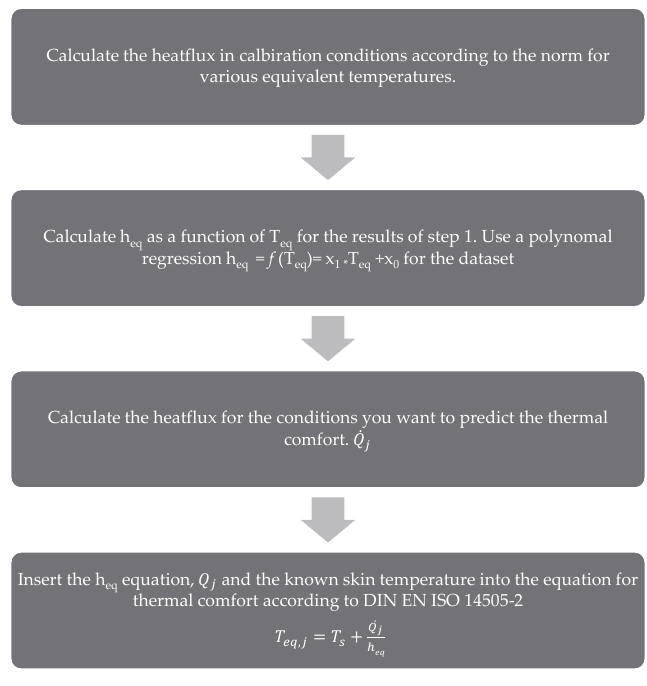
Figure 2. Flow chart for the linearization approach.